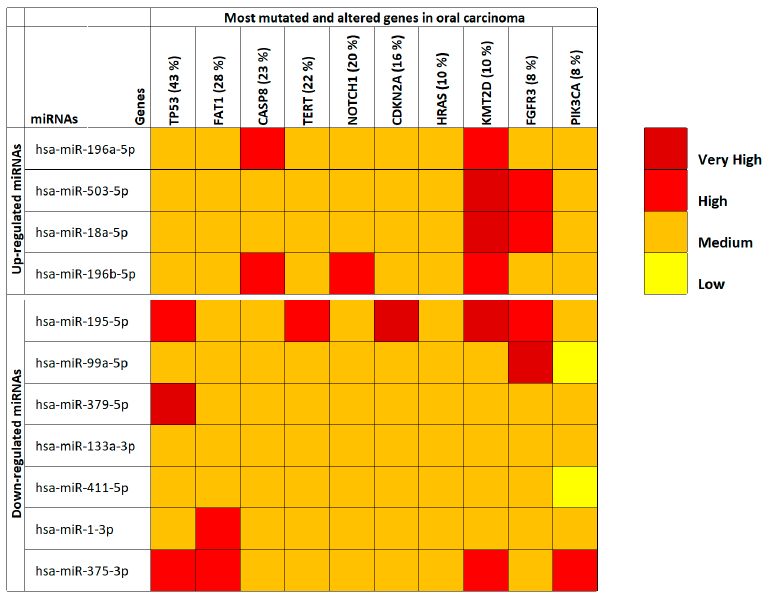
Figure 1. mirDIP analysis of interaction levels between selected miRNAs and the main mutated and altered genes in oral cavity tumors.